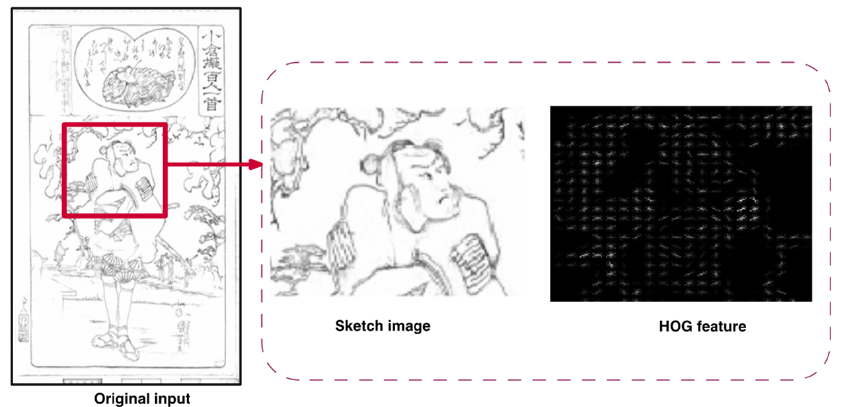
Figure 8. An example of a HOG feature map.